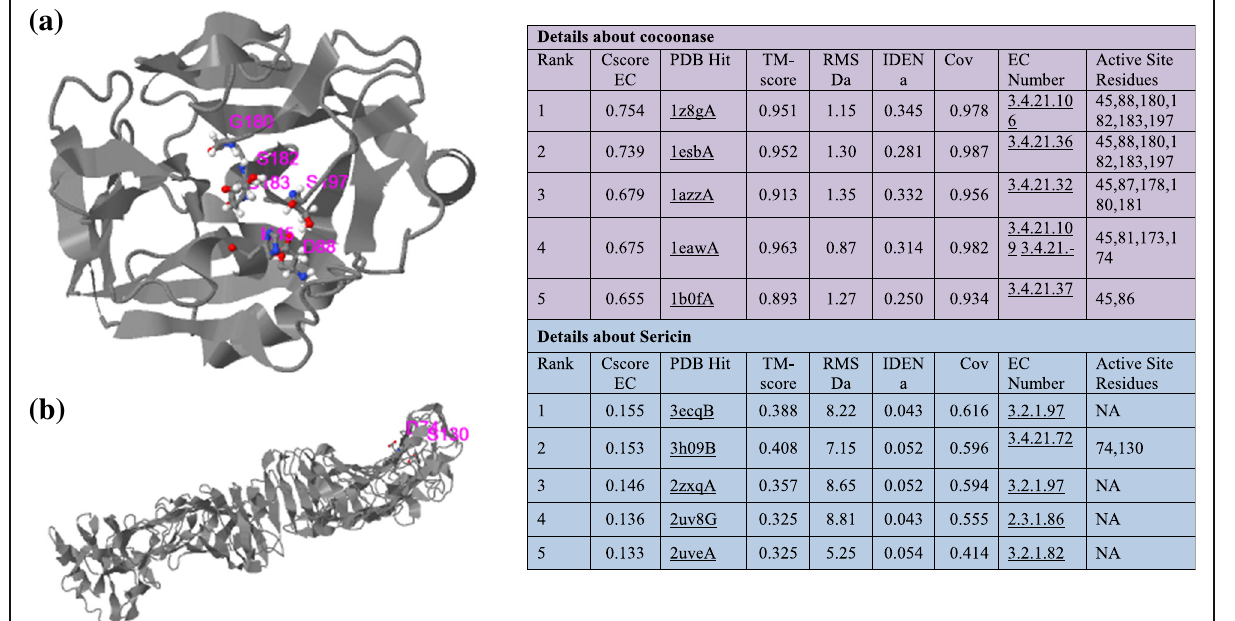
Fig. 7 Predicted Enzyme Commission numbers and active sites for cocoonase ( a ) and sericin ( b ). The first model is predicted based on the template of PDB ID: 1z8gA. The predicted active-site residues are 45, 88, 180, 182, 183, and 197 shown in colored ball-and-sticks for cocoonase having C-score of 0.75, which is showing solid EC number. While for PDB ID: 3h09B, the predicted active-site residues are 74 and 130 shown in colored ball-and-sticks for sericin having C-score of 0.153, which is also predicting solid EC